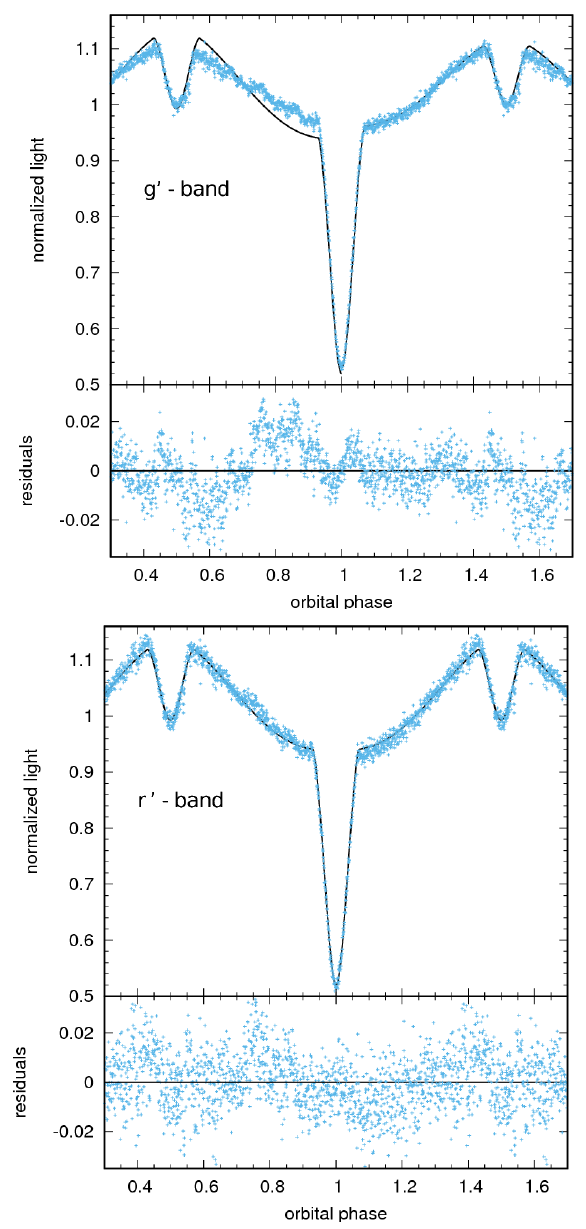
Figure 7. Top: Plot of the fitted green light curve. Left from the pri- mary and right from the secondary minimum: prominent differences between fit and light curve are caused by the atmosphere. Bottom: Plot of the fitted red light curve. The residuals belonging to the plots are shown below each